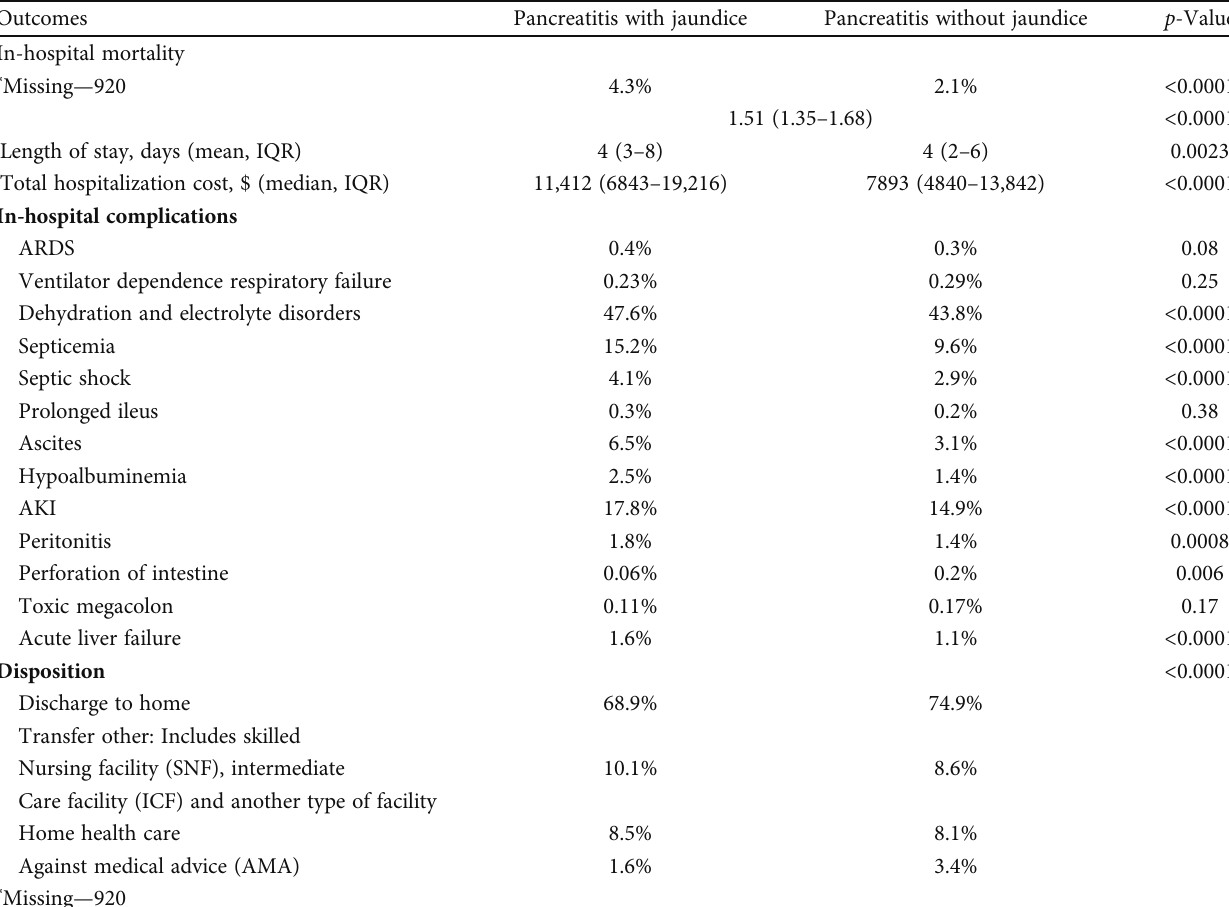
Table 2: Assessment of outcomes.